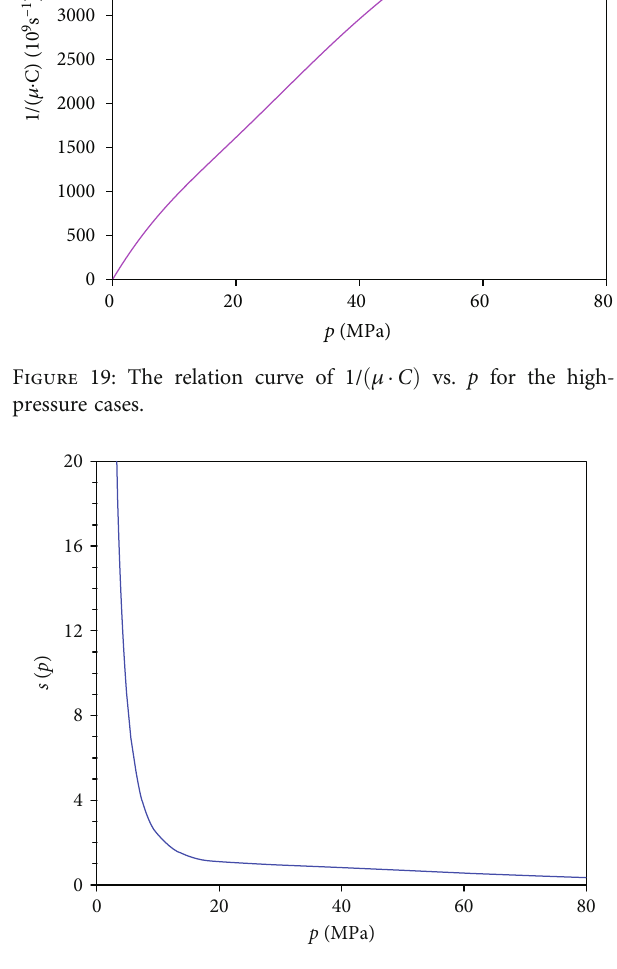
Figure 20: The relation curve of s ð p Þ vs. p for the high-pressure